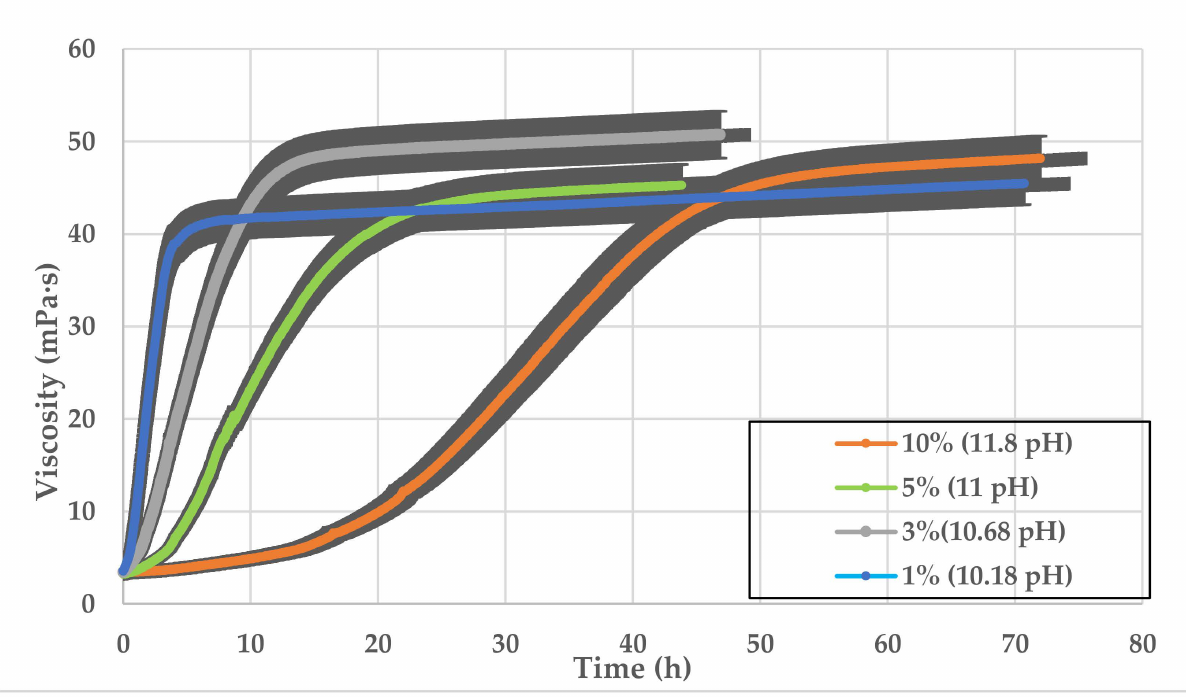
Figure 9. SW based viscosity versus time, 0.5 wt% CMHPG polymer at high pH values of GLDA (13.7) with different GLDA